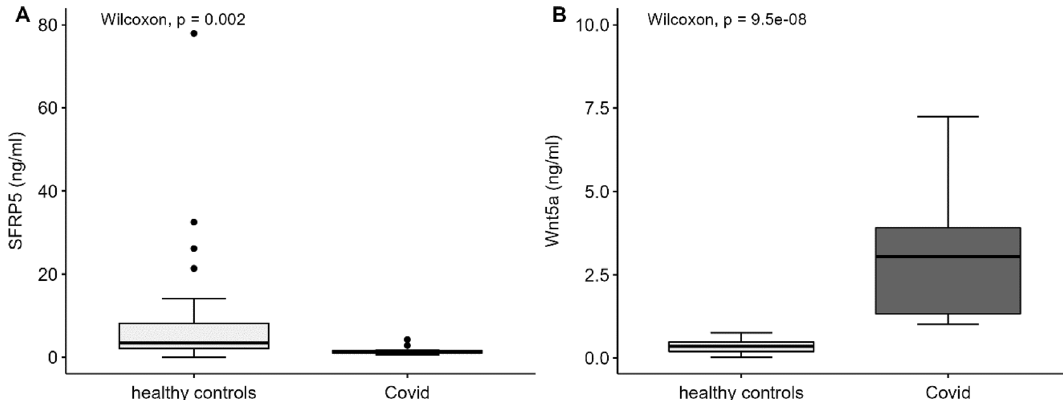
Figure 2. Differences in sFRP5 and Wnt5a levels between patients from ICU cohort with severe Covid-19 infection (cases) and healthy controls from FoCus cohort. ( A ) Subjects with Covid-19 disease showed significant lower sFRP5 levels compared to healthy controls. ( B ) Levels of Wnt5a were significantly increased in cases compared to healthy controls. Wilcoxon Test; statistical significance p <